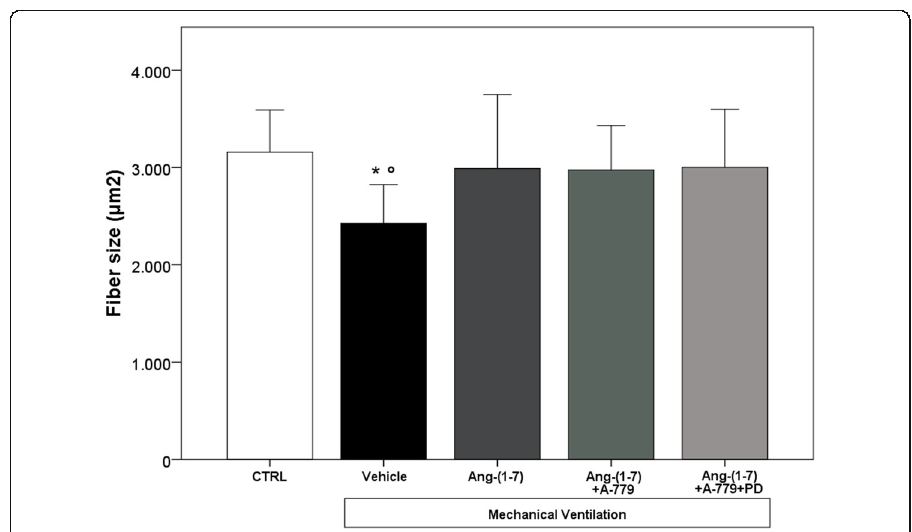
Fig. 2 Diaphragm fiber size. CTRL ( n = 9): unventilated controls; vehicle ( n = 10): VIDD + saline treatment; Ang-(1 – 7) ( n = 13): VIDD + Ang-(1 – 7) treatment; Ang-(1 – 7) + A-779 ( n = 10): VIDD + Ang-(1 – 7) + A-779 treatment; Ang-(1 – 7) + A-779 + PD ( n = 8): VIDD + Ang-(1 – 7) + A-779 + PD123319 treatment; * p = 0.001 vs CTRL; ° p = 0.028 vs Ang-(1 –